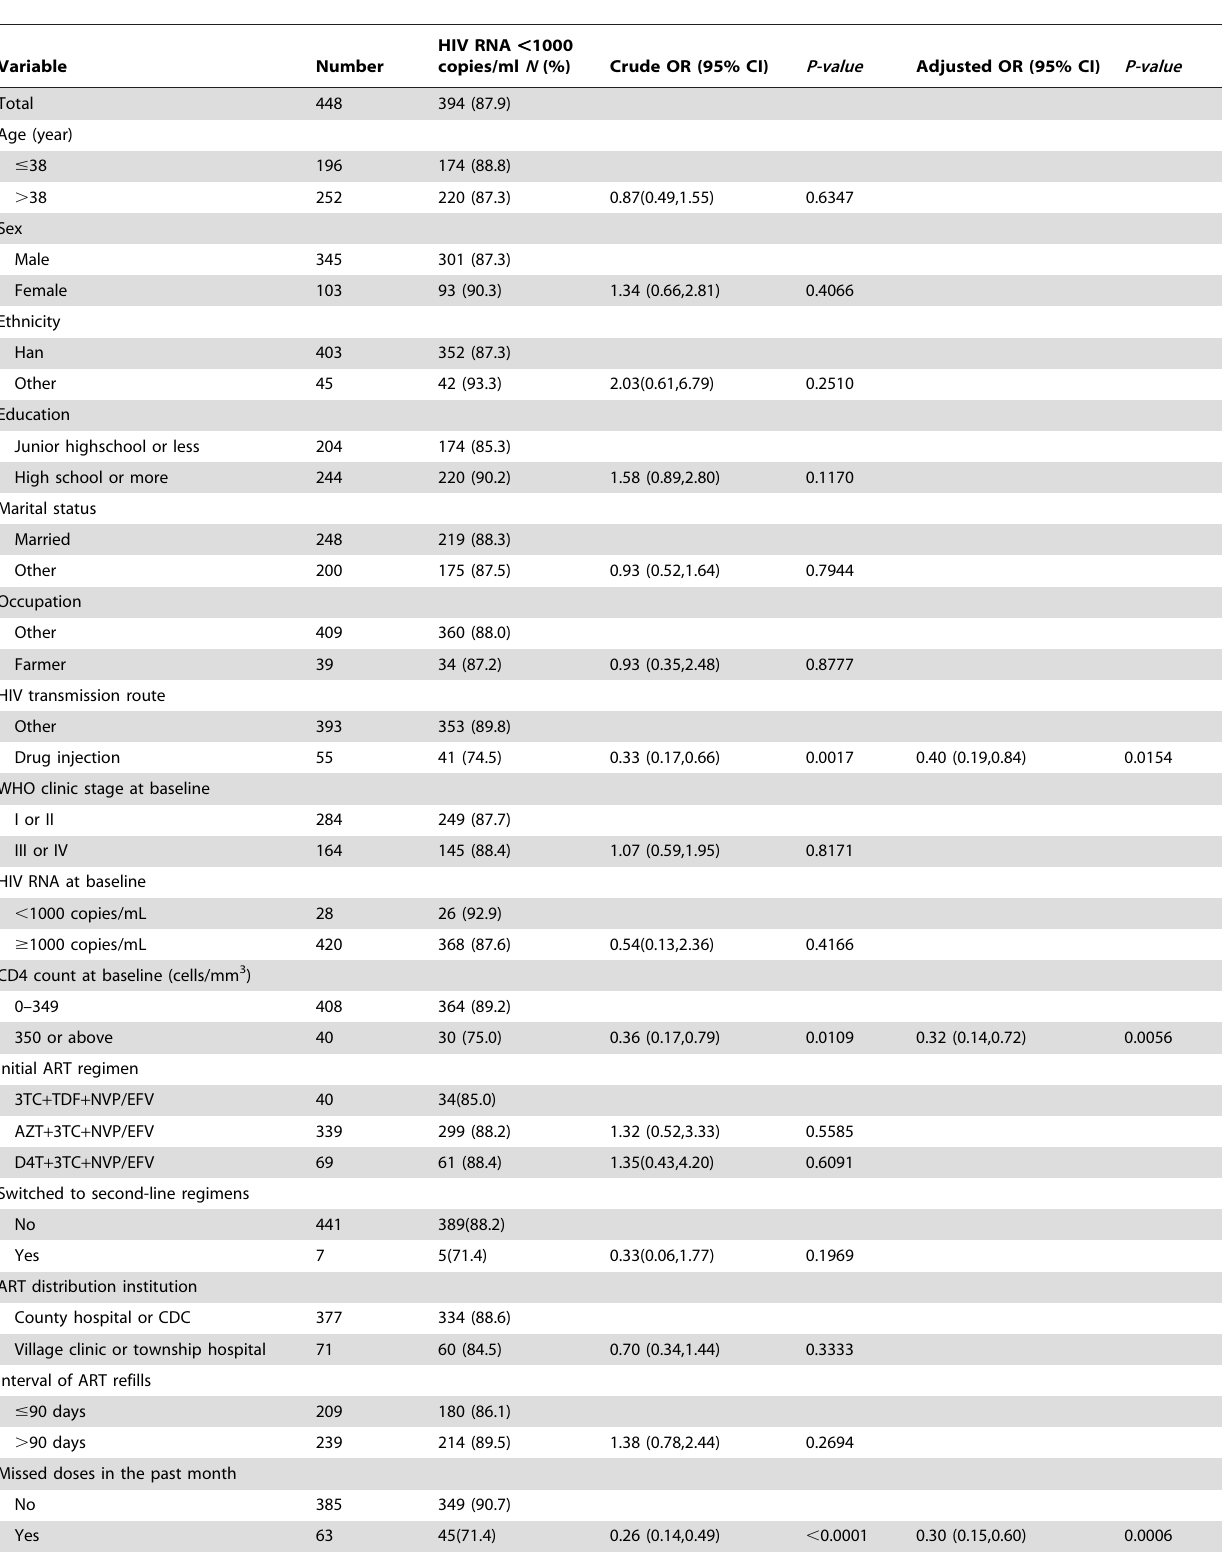
Table 3. Factors associated with HIV RNA , 1000 copies/ml among HIV patients receiving first-line ART at 12 months in four sentinel antiretroviral treatment